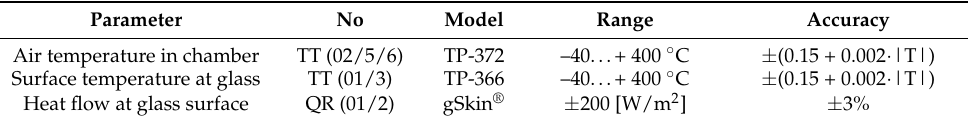
Table 2. Main parameters of the experimental measuring